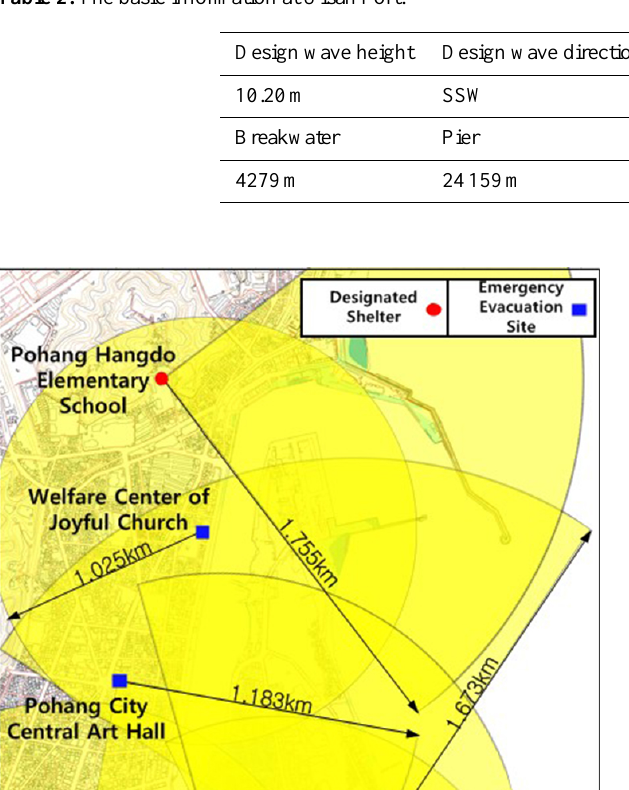
Table 2. The basic information at Ulsan Port.